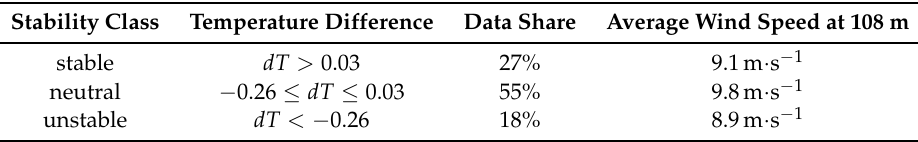
Table 2. Definition of the stability